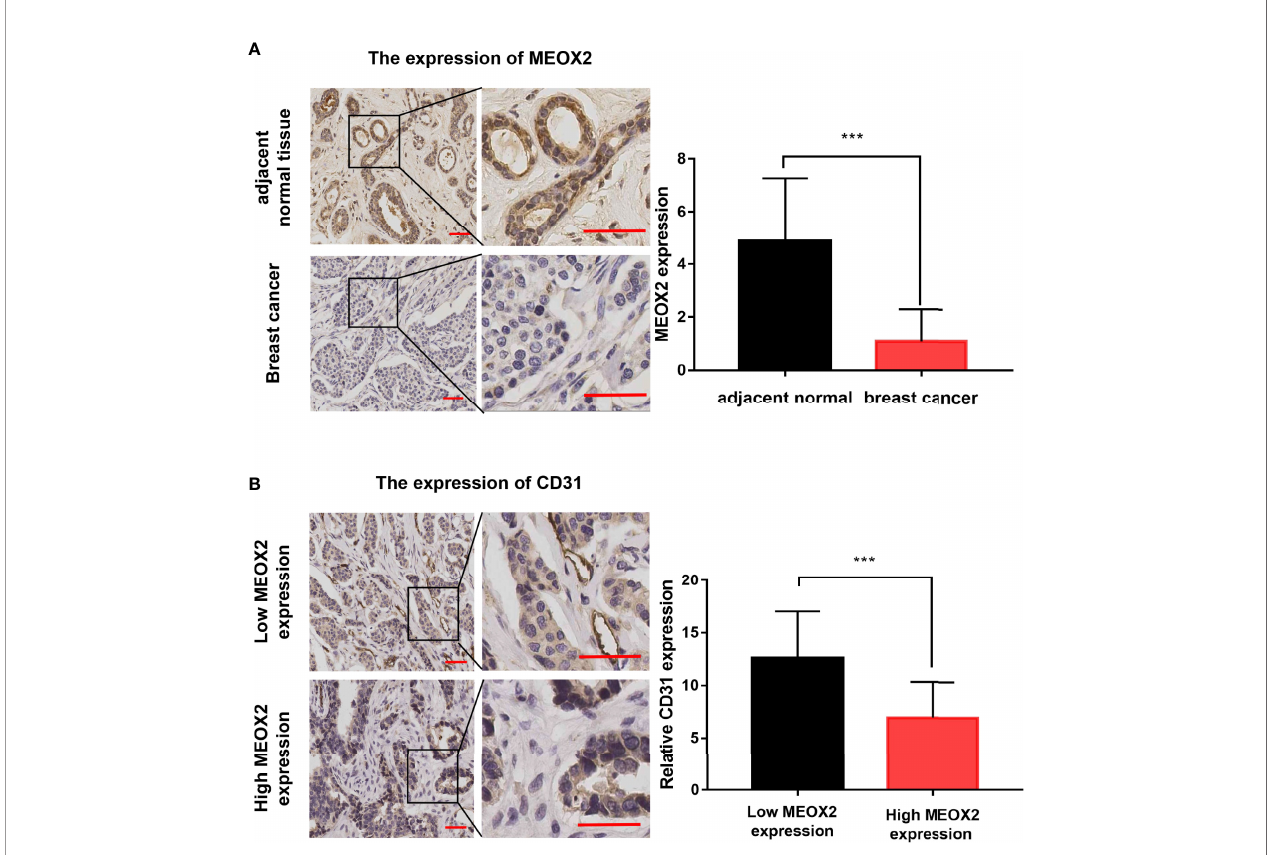
FIGURE 4 | MEOX2 and CD31 expression detected with IHC (A) MEOX2 expression in breast cancer tissues and adjacent normal tissues. Scale bar: 50 m m. Quanti fi cation of IHC scores (addition of intensity score and positive signal area) (n=20) (B) CD31 expression in low MEOX2 group and high MEOX2 group. Scale bar: 50 m m. Quanti fi cation of CD31-positive vessels (n=20). ***p <